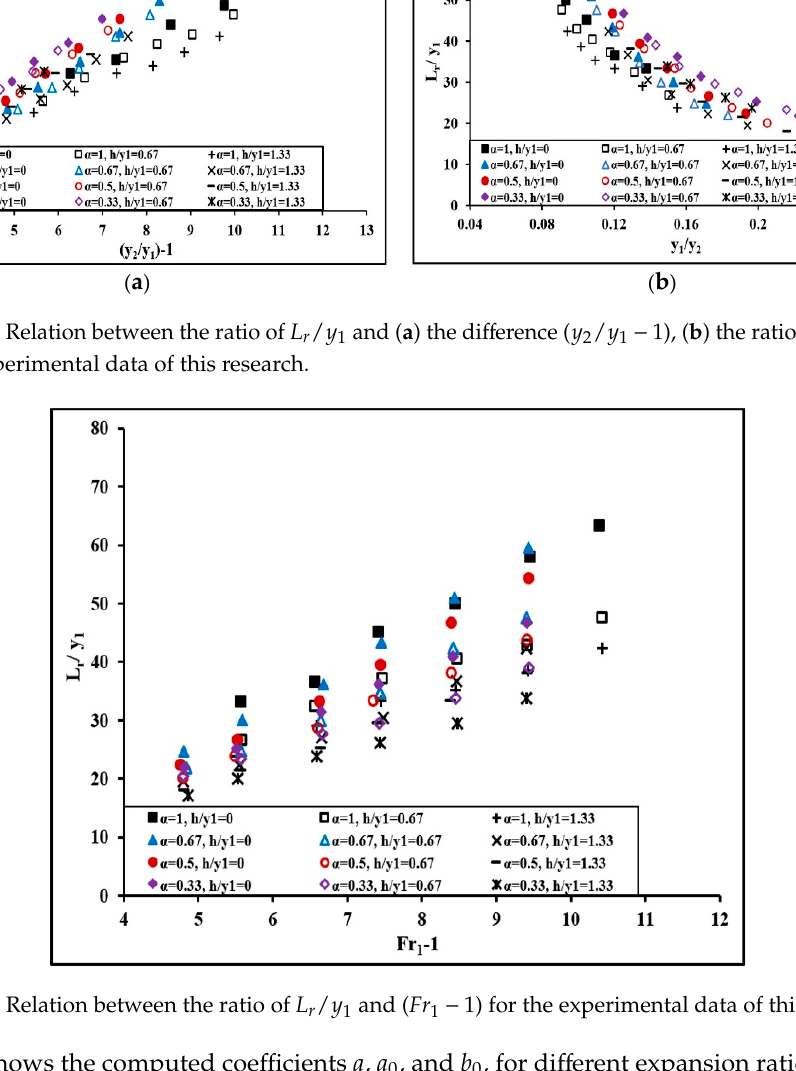
Table 4. Values of a , a (cid:2868) , and b (cid:2868) coefficients obtained from the experimental data of this research and determined by the previous investigations. Reprinted with permission from ASCE.